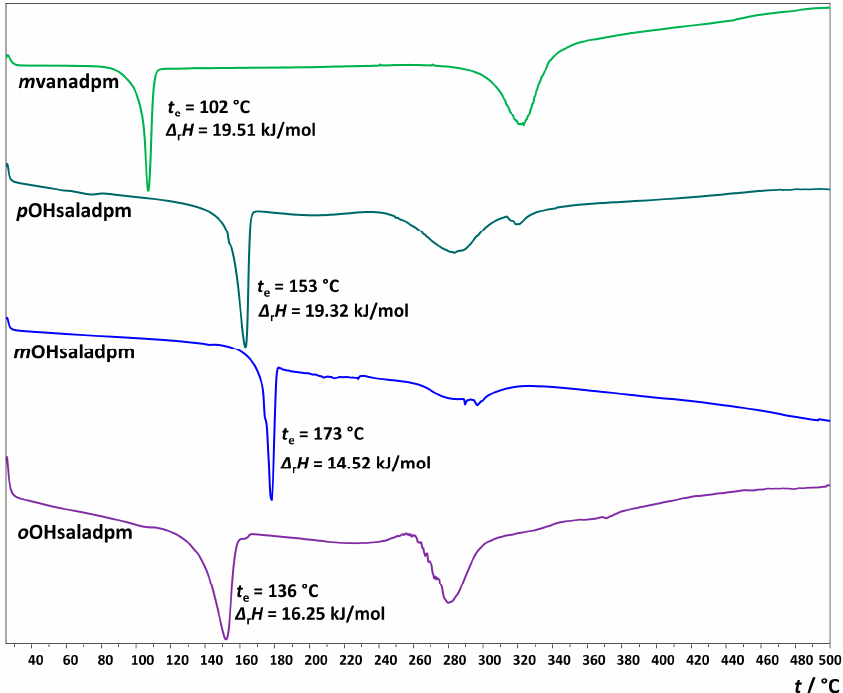
Figure C1. DSC curves of oOHsaladpm (purple), mOHsaladpm (blue), pOHsaladpm (turquoise) and mvanadpm (green).